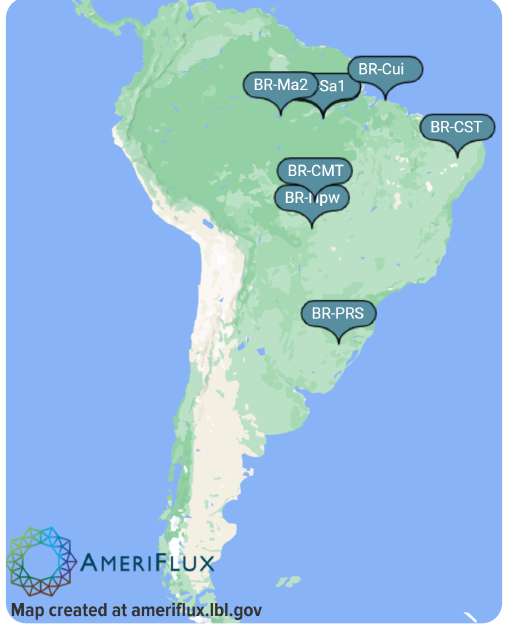
Figure 3. AmeriFlux measurement towers in